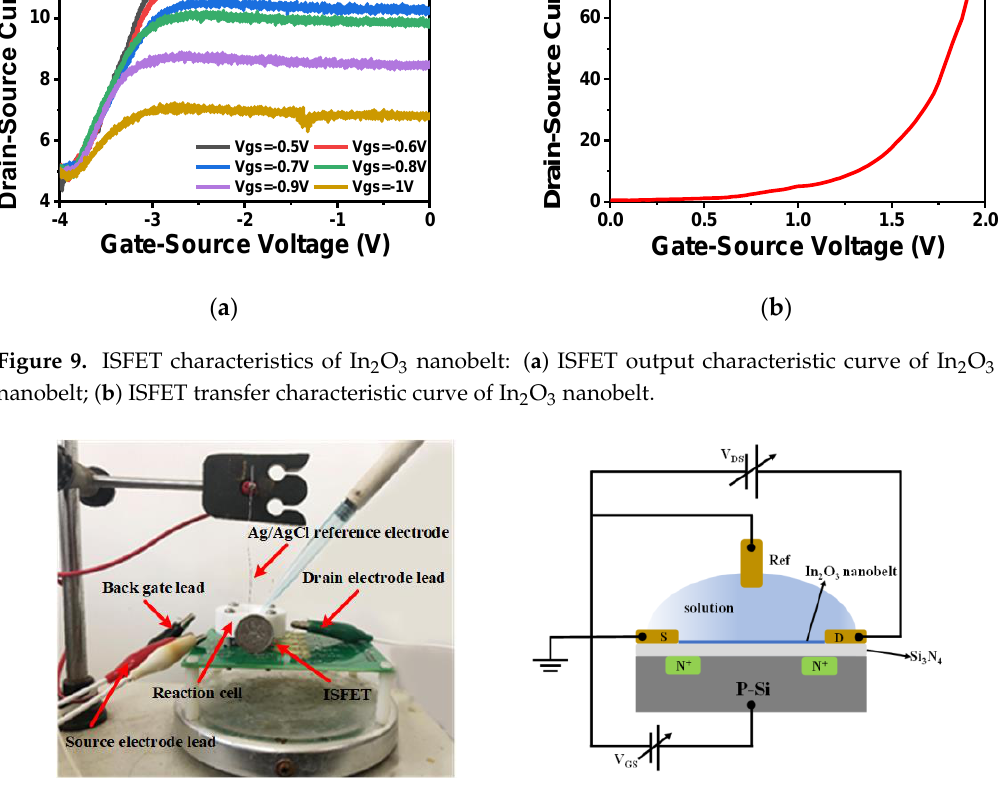
Figure 10. pH detection for micro solution: ( a ) physical map of testing equipment; ( b ) dual-gate (DG) mode electrical connection diagram.